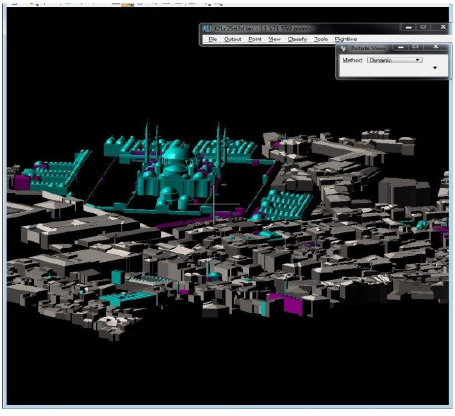
Figure 6: Buildings in DGN format